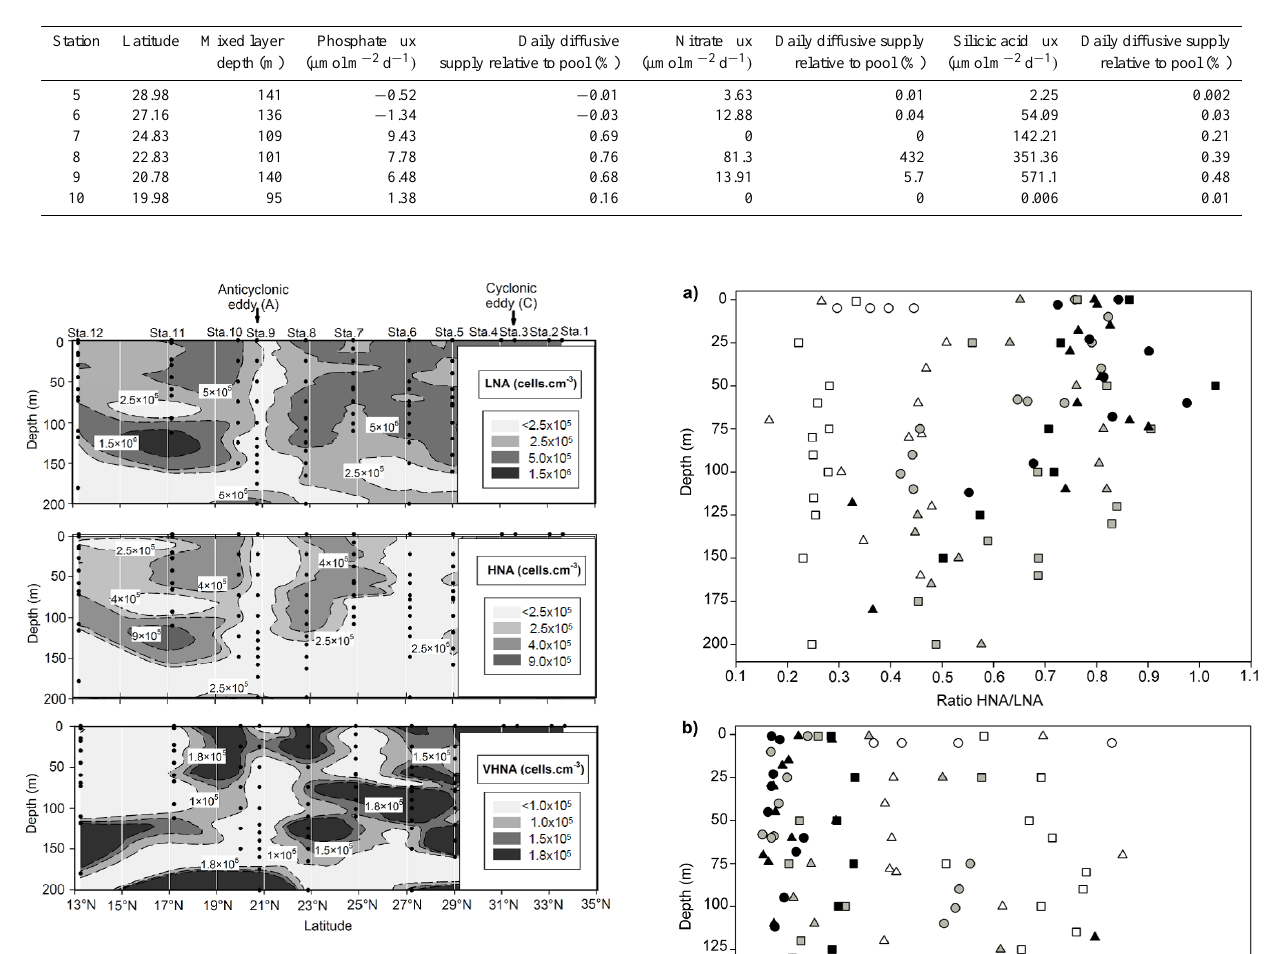
Table 2. Phosphate, nitrate and silicic acid diffusive fluxes into the surface mixed layer and the importance of supply term relative to the standing pool size.